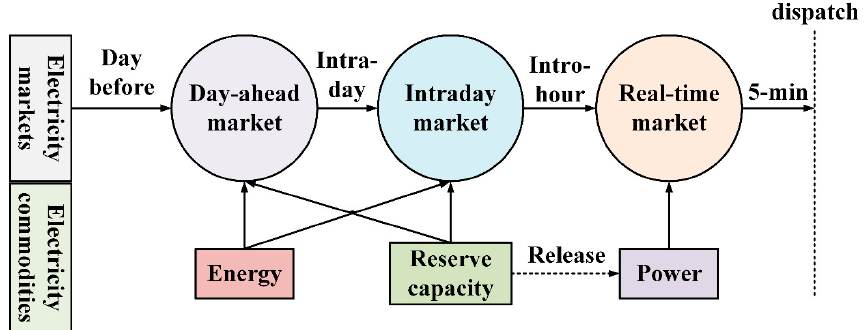
Figure 12. The basic market architecture of advance power system. A smart automated controller makes an optimal decision based on the price signals and more static customers’ preferences in this market architecture.